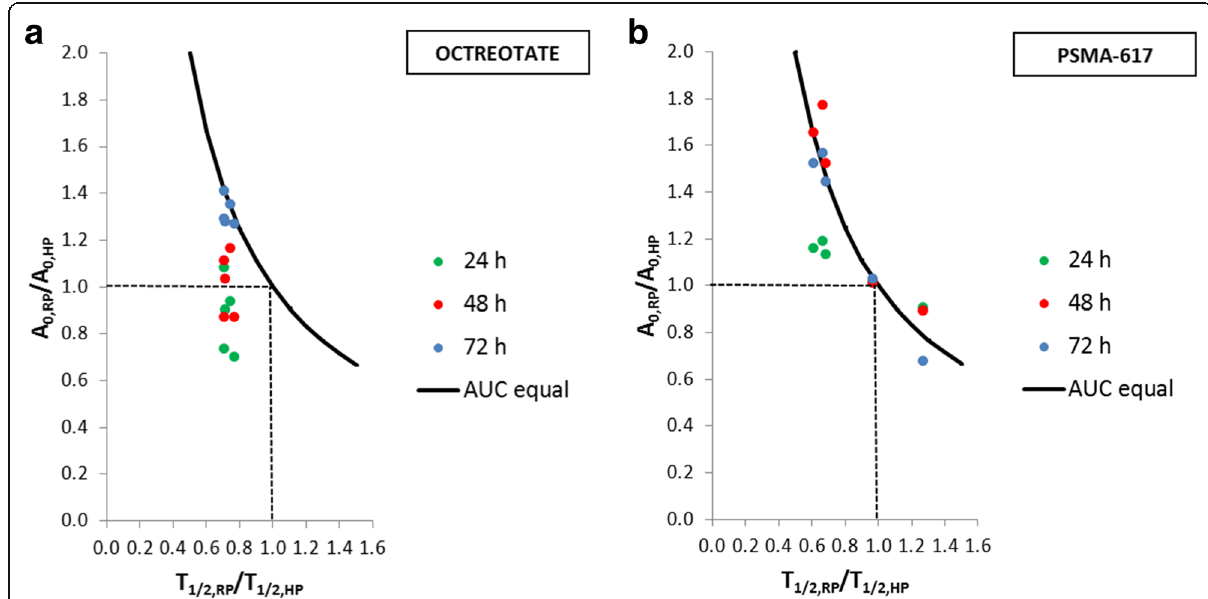
Fig. 7 Evaluation of hybrid-protocol-based TAC parameters in comparison to the reference protocol for both therapies; the ratio of the reference- protocol-based and SPECT-based effective half-lives ( T 1/2,RP / T 1/2,HP ) and the ratio of the y -axis intercepts for the reference-protocol-based and the hybrid-protocol-based TACs ( A 0,RP / A 0,HP ) are provided; the black curve indicates the optimal case, for which the area under both TACs (AUC) is